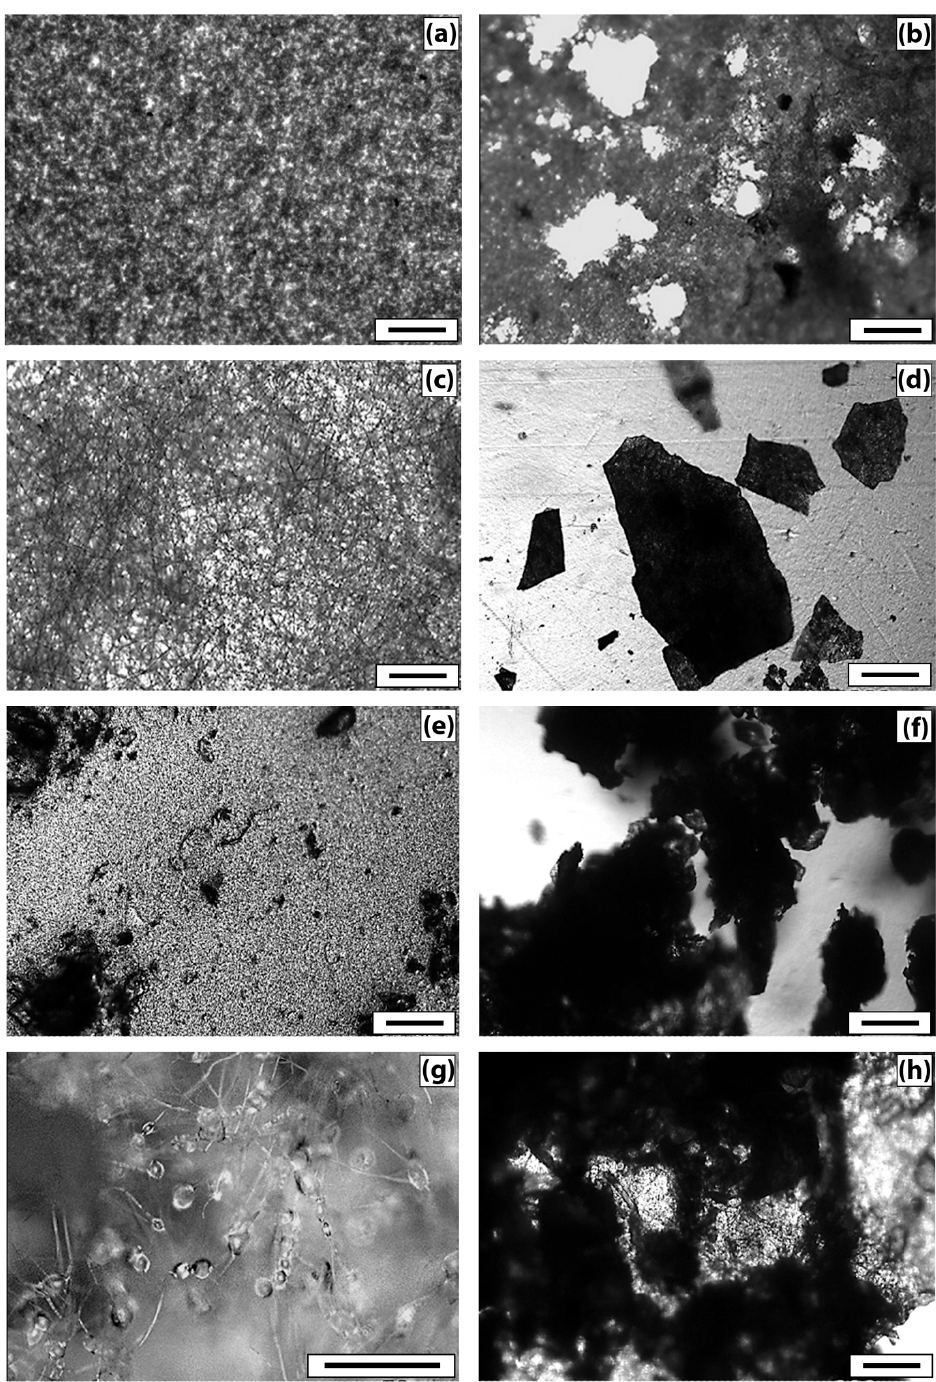
Figure 5. Optical micrographs of PHB (film) samples—( a ) initial and ( b ) after 60 days of tests by the Sturm method; PHB (fiber)—( c ) initial and ( d ) after 60 days of tests by the Sturm method; PHB/CHT (film) —(50/50)—( e ) initial and ( f ) after 60 days of tests by the Sturm method; and PHB/CHT (fiber)—(60/40)—( g ) initial and ( h ) after 60 days of tests by the Sturm method). The size of the scale bar—100 µm.